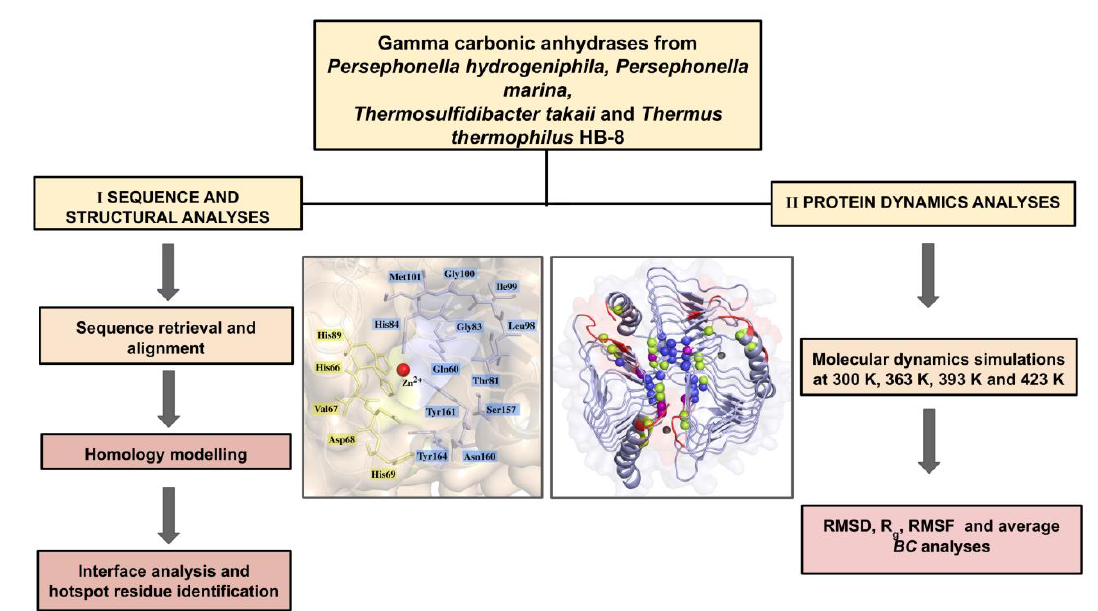
Figure 9. General methodology followed in this work. RMSD, R g , RMSF, and BC refer to root mean square deviation, radius of gyration, root mean square fluctuation and betweenness centrality respectively.